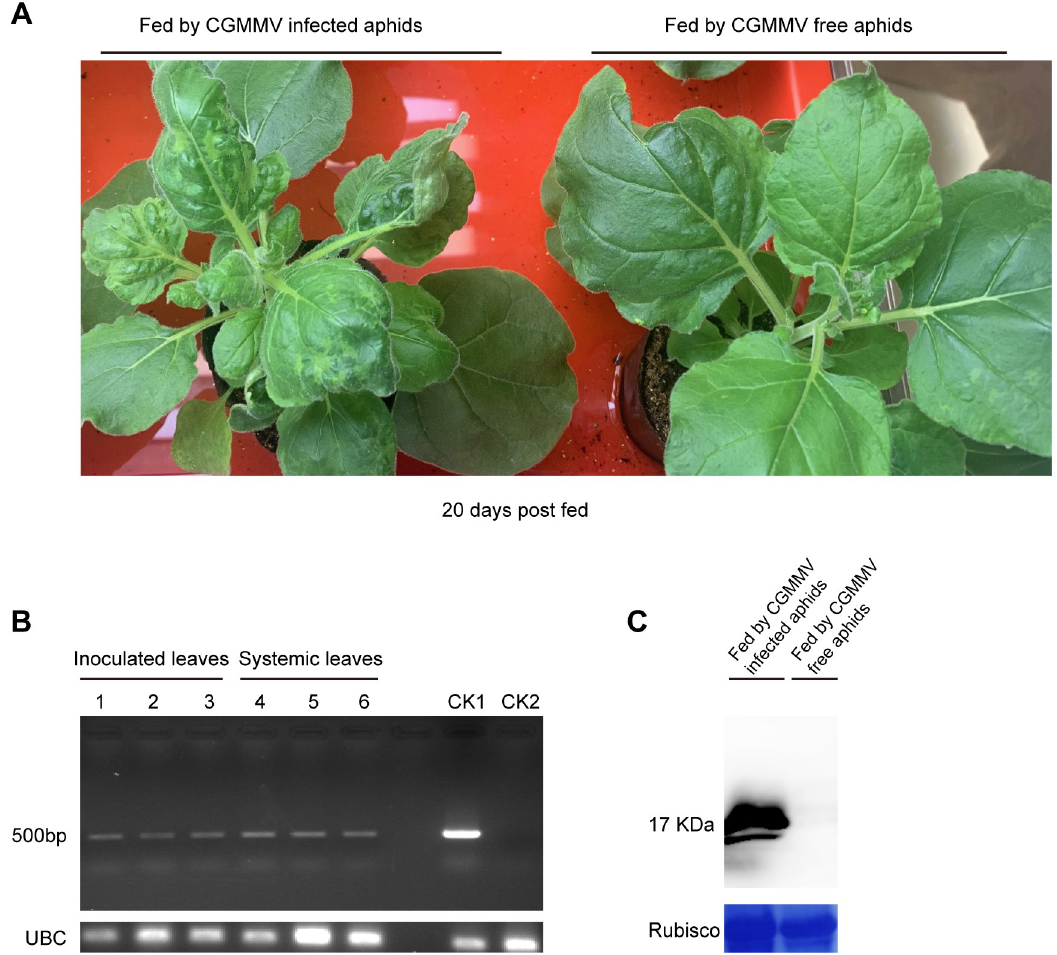
Fig 4. Transmission of CGMMV to N . benthamiana by M . persicae . (A) Symptom development of N . benthamiana plants fed by CGMMV-infected and CGMMV-free M . persicae at 20 day post fed. (B) RT-PCR analysis on CGMMV in systemic leaves and leaves inoculated with the CGMMV-infected M . persicae . CK1, positive control (CGMMV-infected N . benthamiana plants); CK2, negative control (CGMMV-free N . benthamiana plants). dpi: days post inoculation. (C) Western blotting analysis on the systemic leaves of N . benthamiana plants fed by CGMMV-infected and CGMMV-free M . persicae .